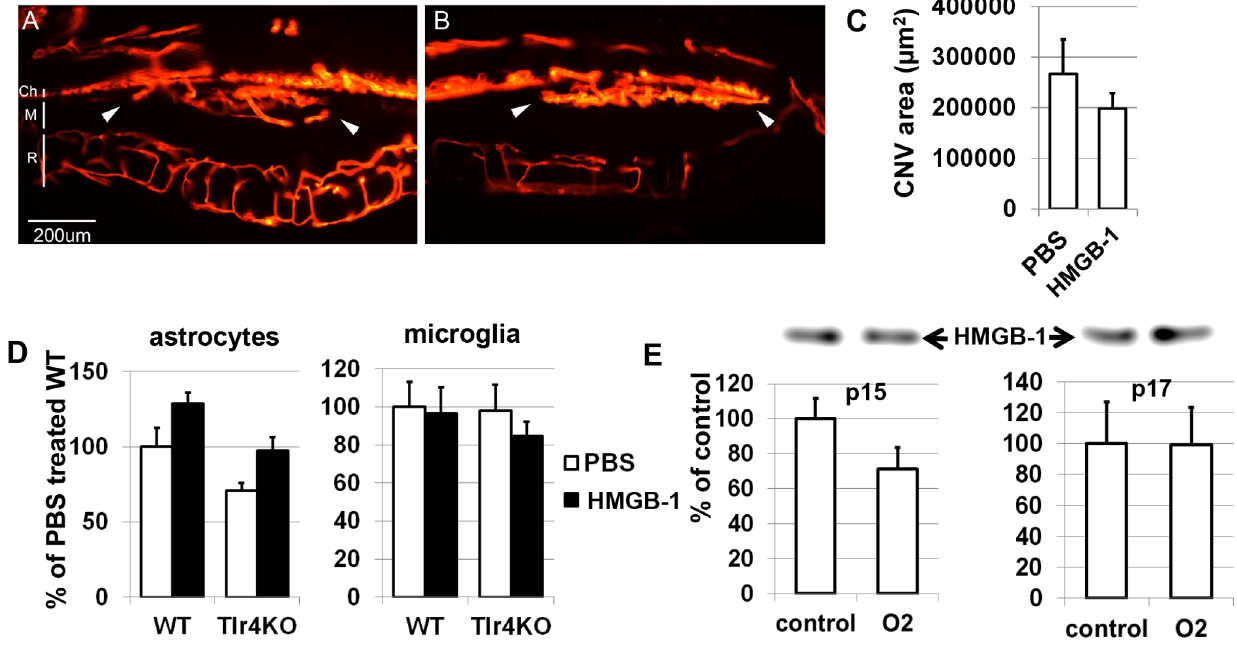
Figure 6. There was no association found between the level of HMGB-1 and neovascularization in the retina. Neovascularization was induced by subretinally injecting Matrigel either with PBS ( A ) or mixed with HMGB-1 ( B ). Neovascularization was allowed to develop for 10 days. Blood vessels were labeled with DiI and visualized by fluorescence microscopy (white arrows indicate neovascularization in the Matrigel injected area. Ch, choroids; M, Matrigel, R retina. Scale bar: 200 m m). ( C ) Quantitative analysis shows no difference in the levels of neovascularization between HMGB1-treated eyes compared to control eyes. ( D ) VEGF-A expression was not changed in glial cells (astrocytea and microglia) treated with HMGB-1 and PBS (control). ( E ) Examination by western blot of vitreous humor from both hyperoxia-injured and room air control animals (obtained from postnatal days 15 and 17 pups) did not show a statistically significant difference between them. Results of analysis of western blots (top) are expressed as a percentage of corresponding value in the control eyes 6 SEM (n=6).